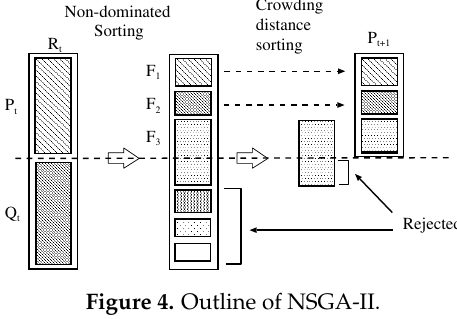
Figure 4. Outline of NSGA-II.